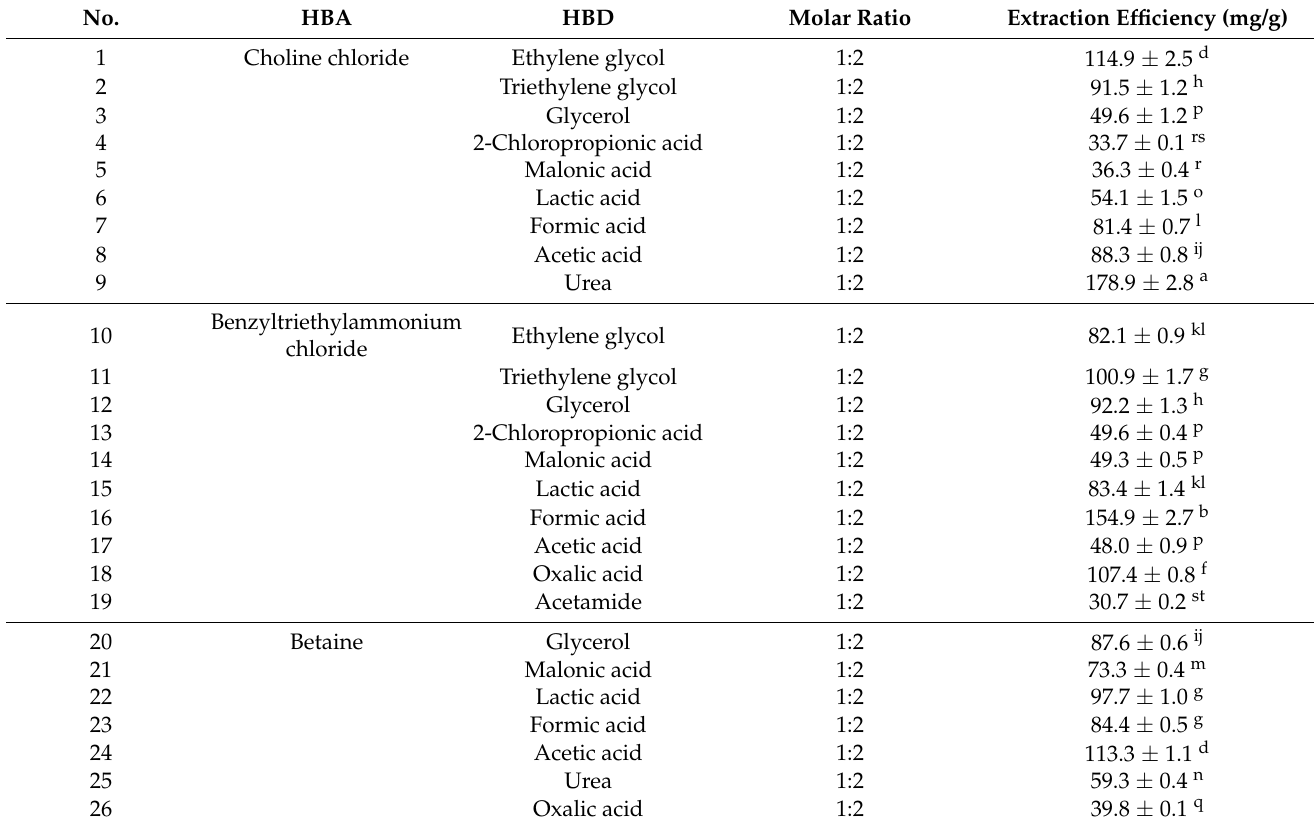
Table 1. The extraction efficiencies of flavonoids with different DES